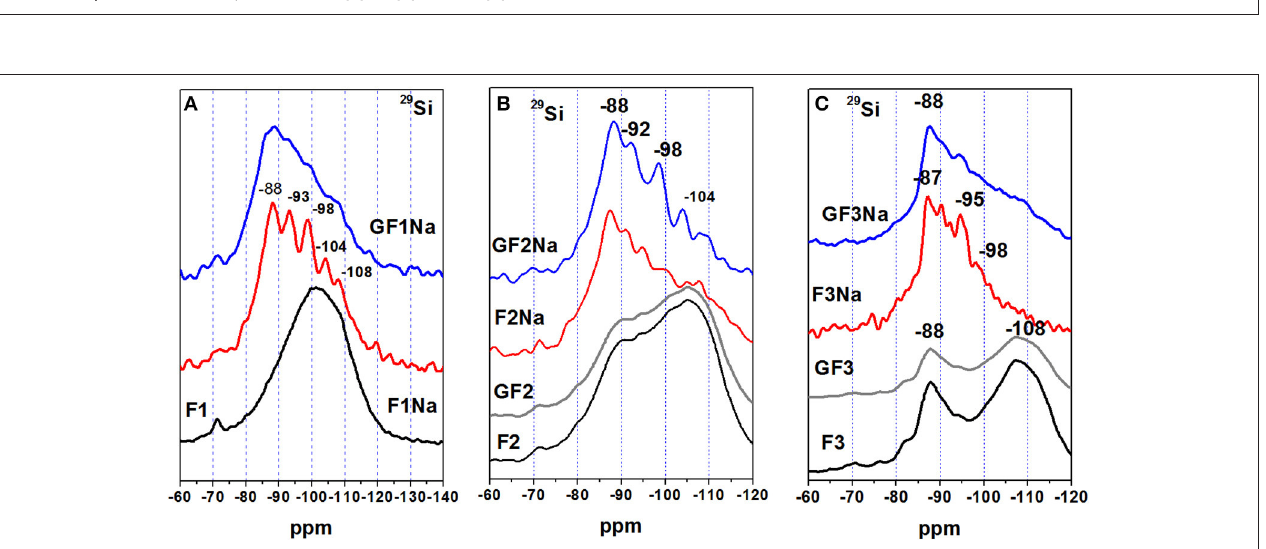
FIGURE 4 | 29 Si MAS-NMR spectra for ash (A) F1 (B) F2, and (C) F3.